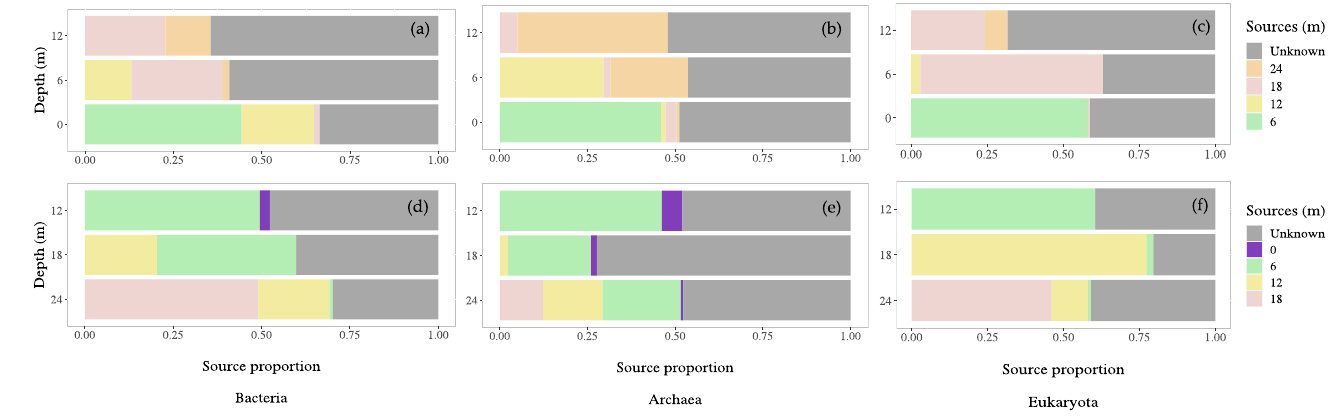
Figure 4. Discriminative features of bacterial ( a ), archaeal ( b ) and eukaryotal ( c ) taxa between planktonic and sessile communities at the genus level, using LEfSe analysis (log LDA threshold > 2, p < 0.05).